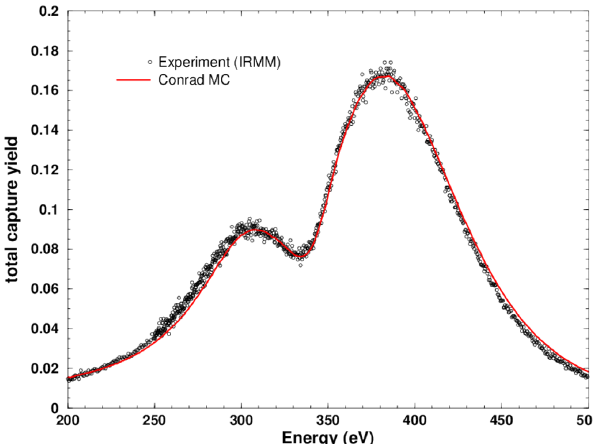
Fig. 5. Comparison between experimental values and theoret- ical description with multiple-scattering corrections for 55 Mn neutron induced capture yields. Figure taken from